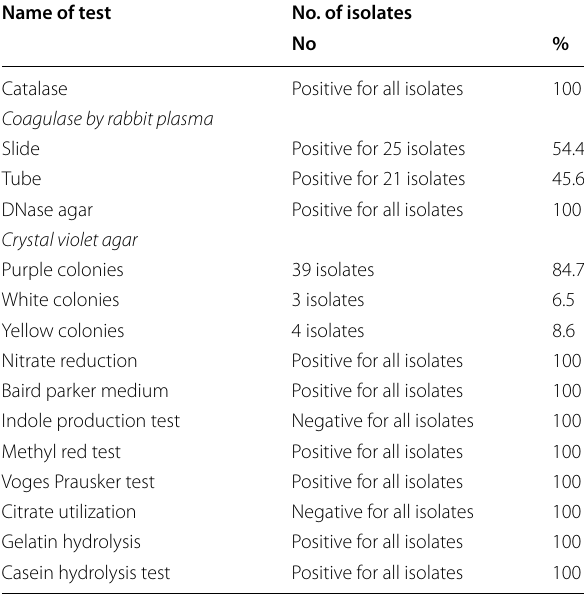
Table 3 Biochemical characterization of S. aureus